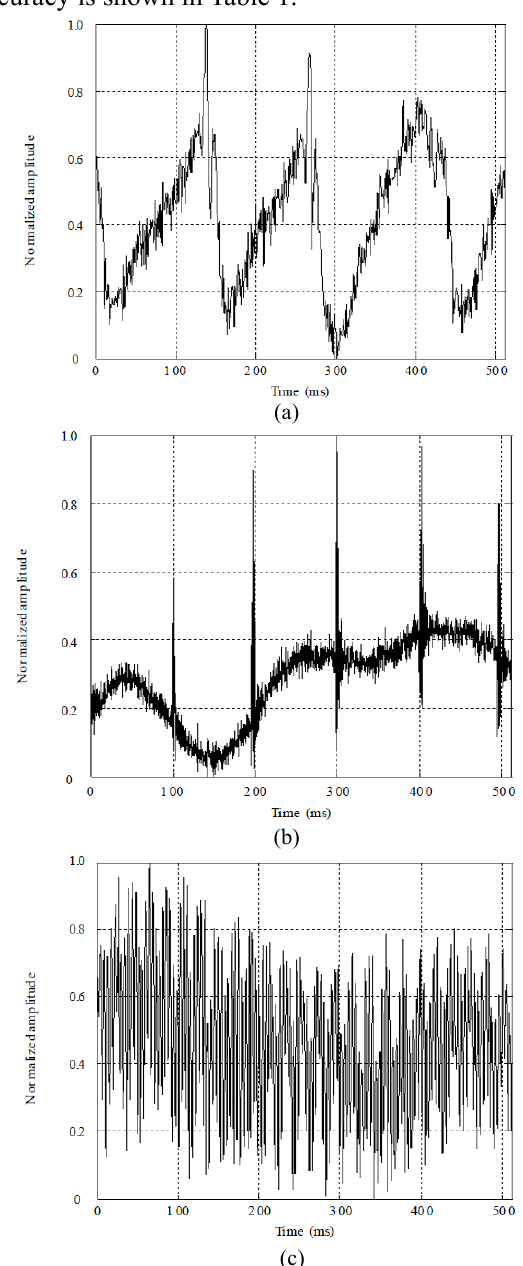
Fig. 6 Original vibration signal of system: (a) walking signals, (b) manual operation signals, and (c) mechanical